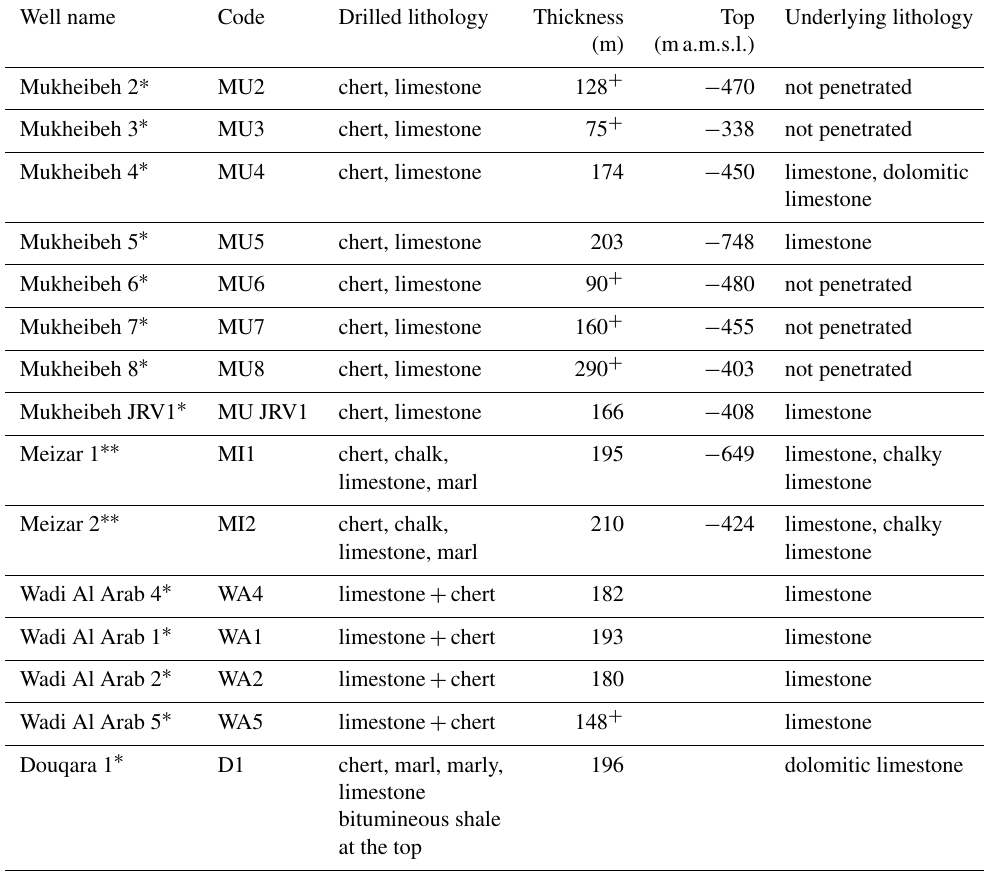
Table 1. Campanian chert-bearing formation (B2) – thickness and elevation in wells adjacent to the LYG. Well